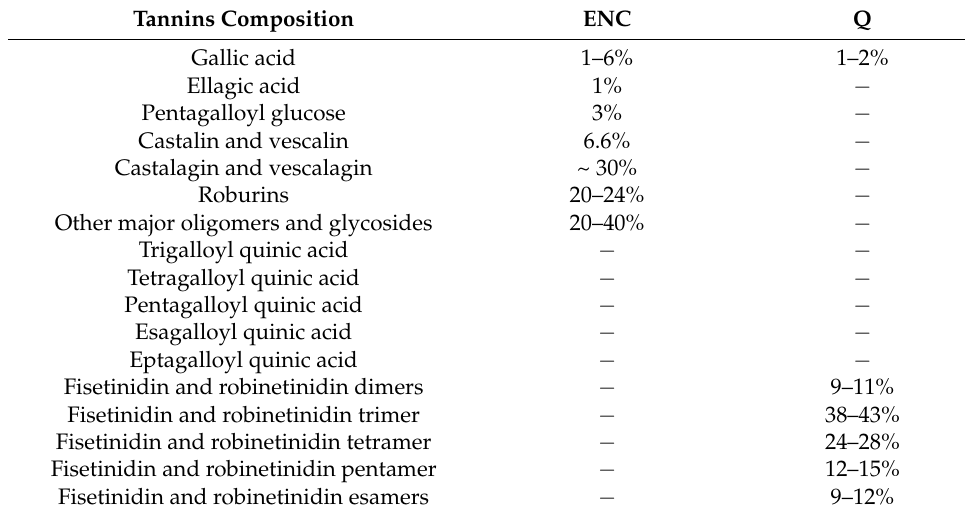
Table 2. ENC and Q chemical